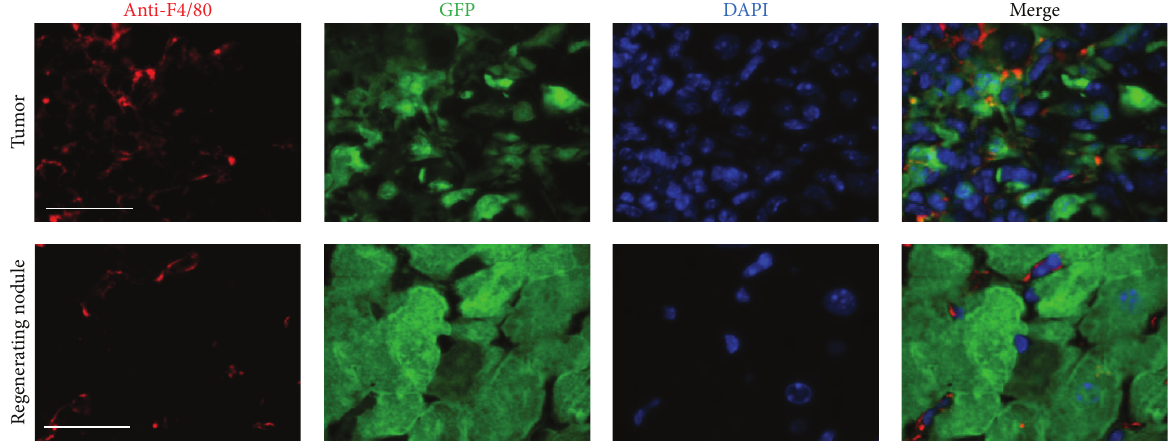
Figure 7: Comparison of macrophages in regenerating nodules and liver tumors. Sections were stained with an anti-F4/80 antibody (red). Immunofluorescence was used to detect donor BMC-derived GFP (green). Markedly increased numbers of macrophages were observed in the tumor area compared to those in regenerating liver nodules. Scale bar represents 60 𝜇